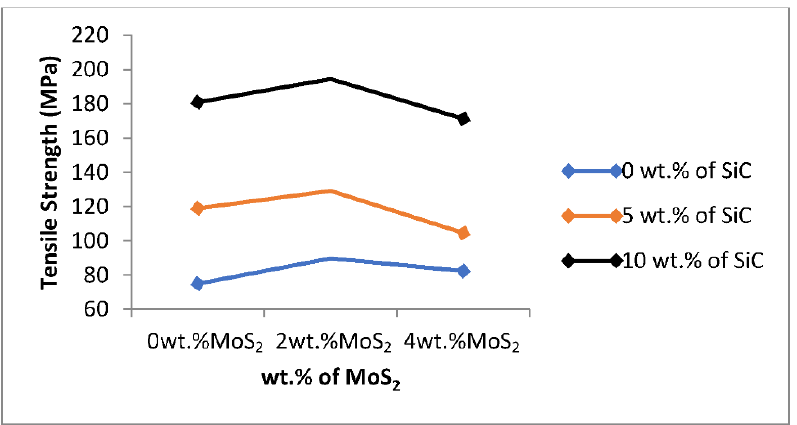
Figure 5. Effect of process parameters on tensile strength.